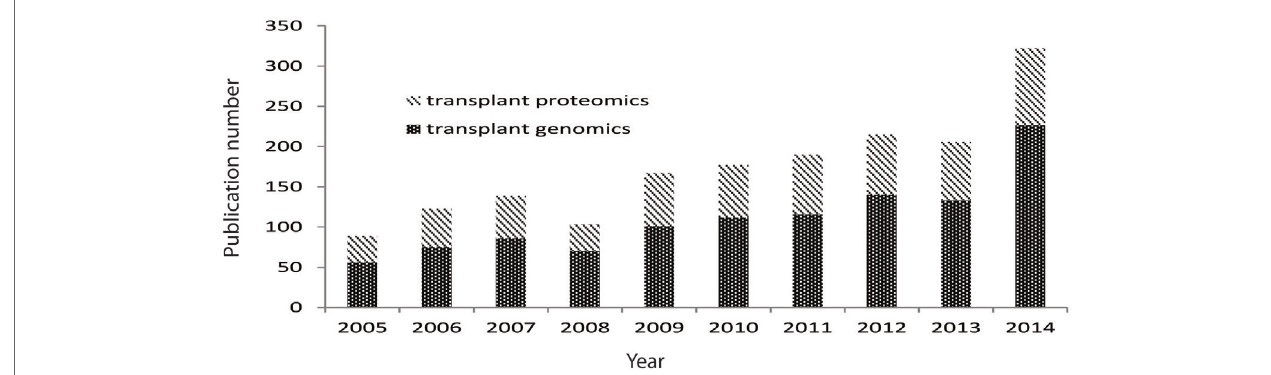
FiGURe 2 | Pubmed publications on transplant genomics and proteomics paper over last 10 years . Data were extracted from Pubmed by searching transplant and genomics or transplant and